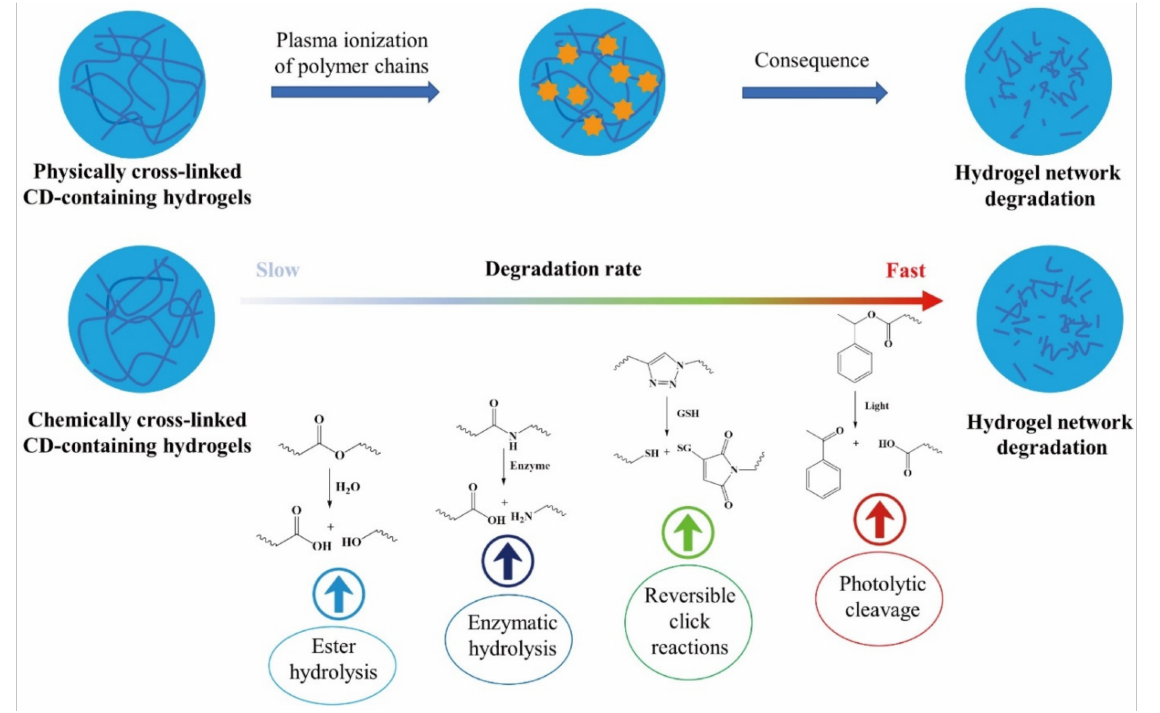
Figure 2. Simulated degradation behavior for CD-containing